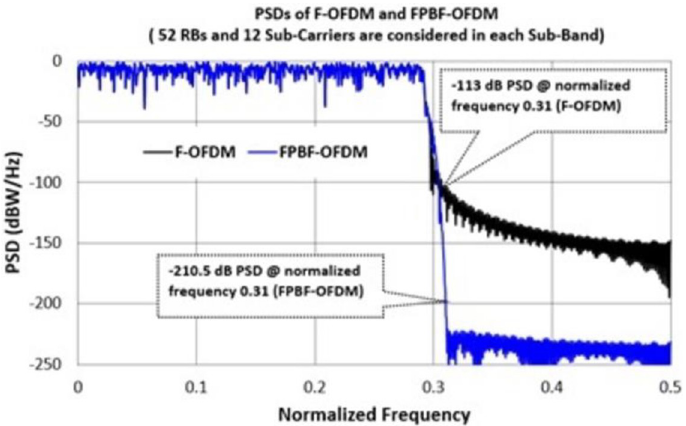
Fig 3. Power spectral densities (PSDs) of F-OFDM and FPFB-OFDM.